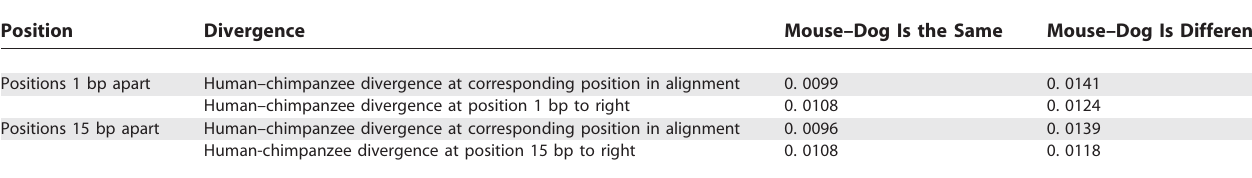
Table 2. Human–Chimpanzee Divergence at Adjacent Sites in Multiple Alignments with Mouse and Dog Position Divergence